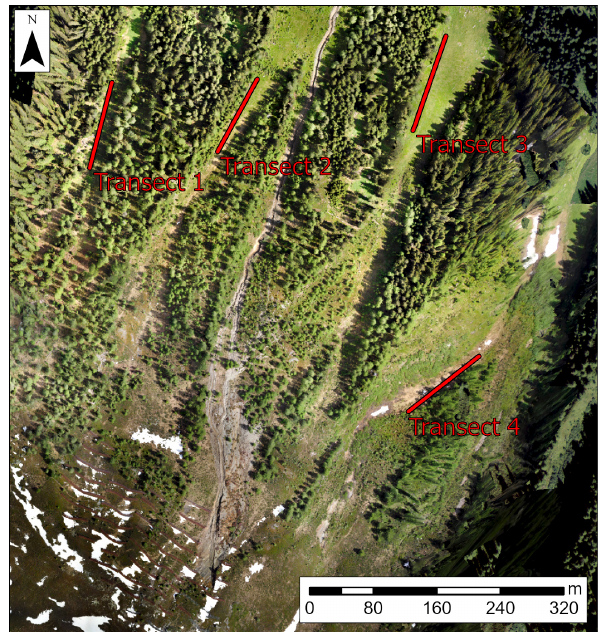
Figure 3. Four transects within gullies in the Braema study area (Grisons, Switzerland; orthophoto from the drone flight, 2019). The surface roughness was analysed using non-directional and direc- tional SD of residual topography.